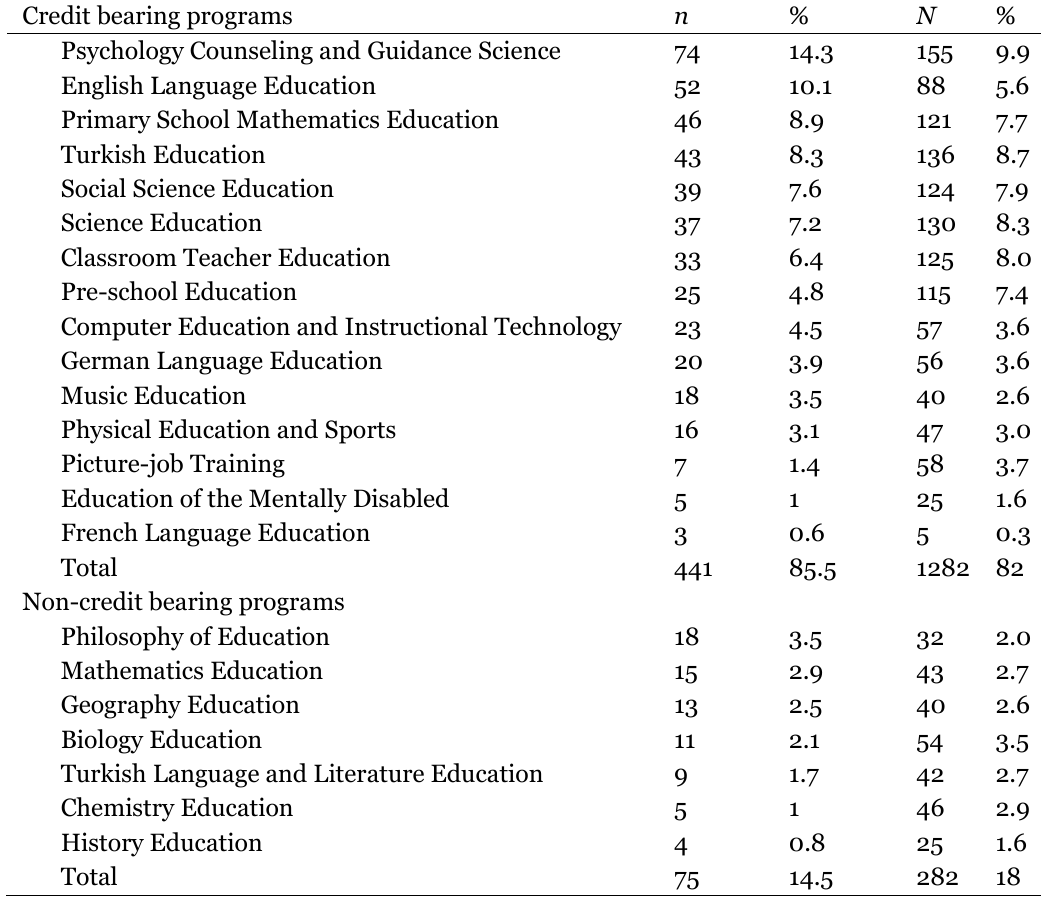
Distribution of Participants’ Program According to Credit